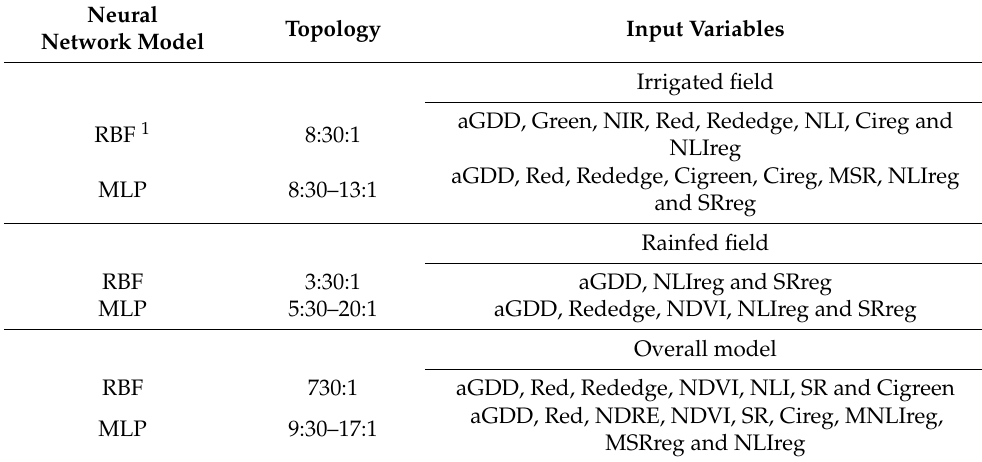
Table 2. Resultant models and their topologies; input used for each field. Neural